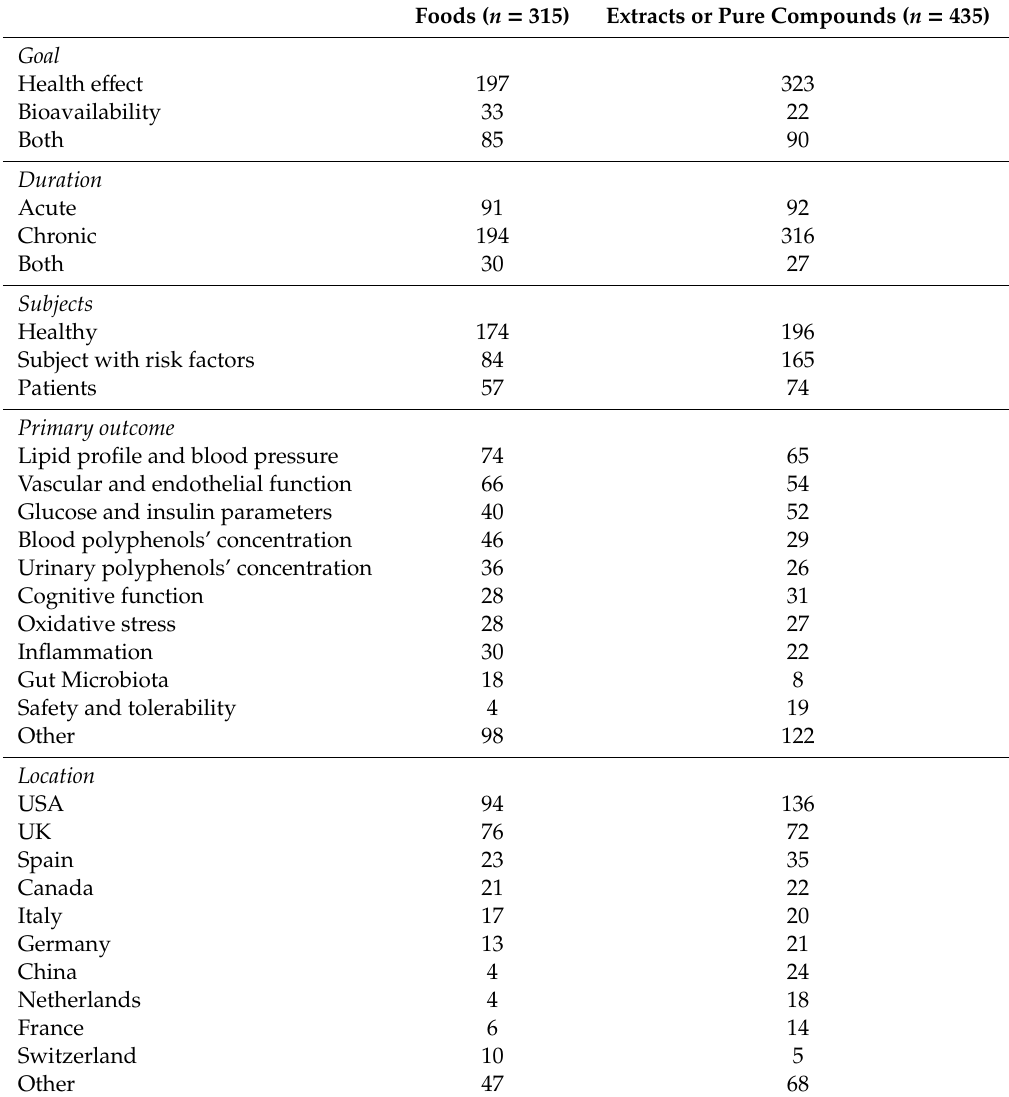
Table 2. Characteristics of the included studies ( n =